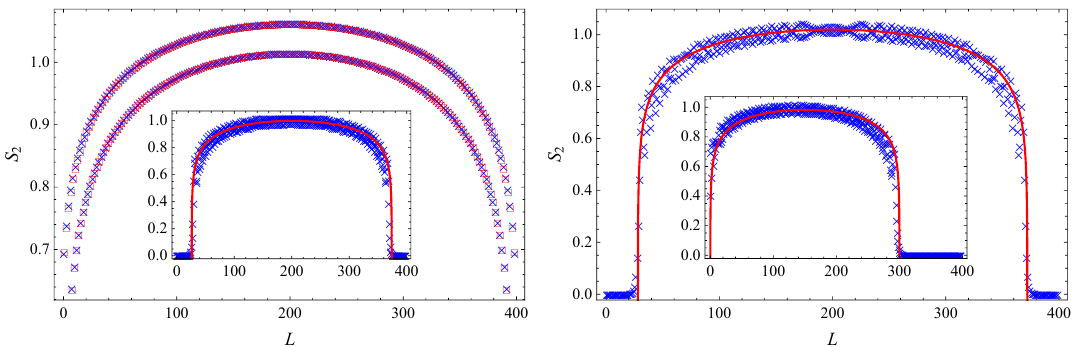
Figure 4 . Left: Rényi entanglement entropy S 2 for the Krawtchouk chain with q = 1 / 2 and N = 400 spins at half filling (blue crosses) compared to its asymptotic approximation (4.14)–(7.6) (red squares). The inset shows a similar plot for k F = π/ 4 , compared to its heuristic approxima- tion (6.8)–(7.7). Right: analogous plot for q = 1 / 4 at half filling (main plot) and for k F = π/ 4 (in-